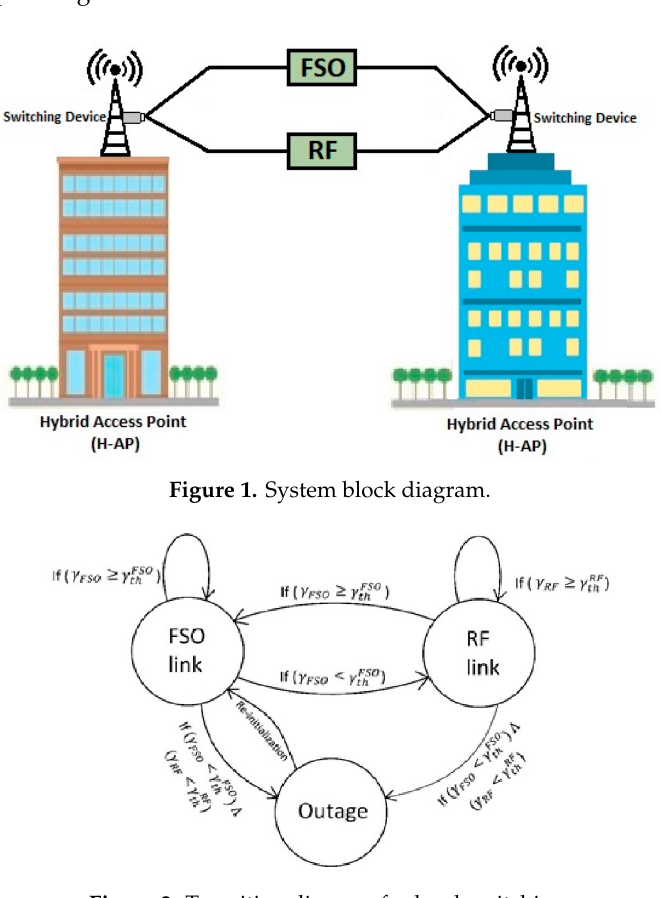
Figure 2. Transition diagram for hard-switching.